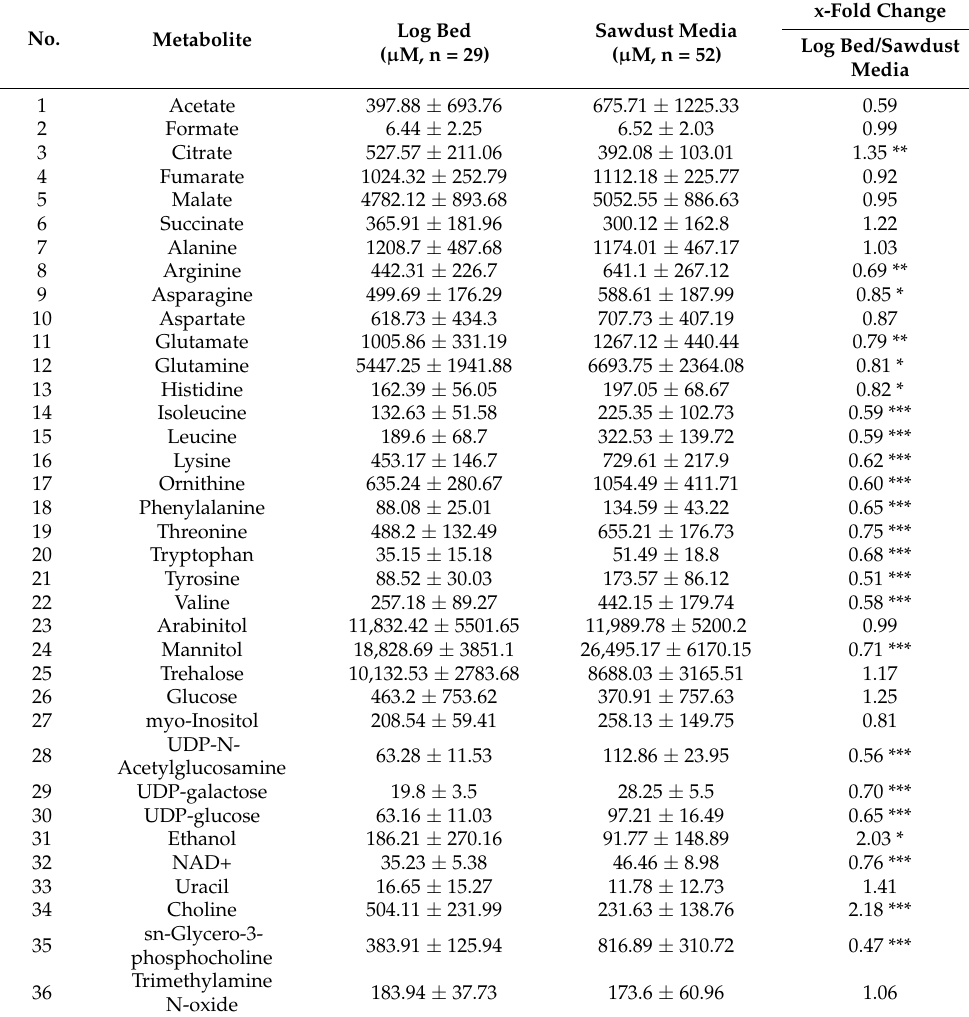
Table 1. Metabolites detected by 1 H NMR in Lentinula edodes